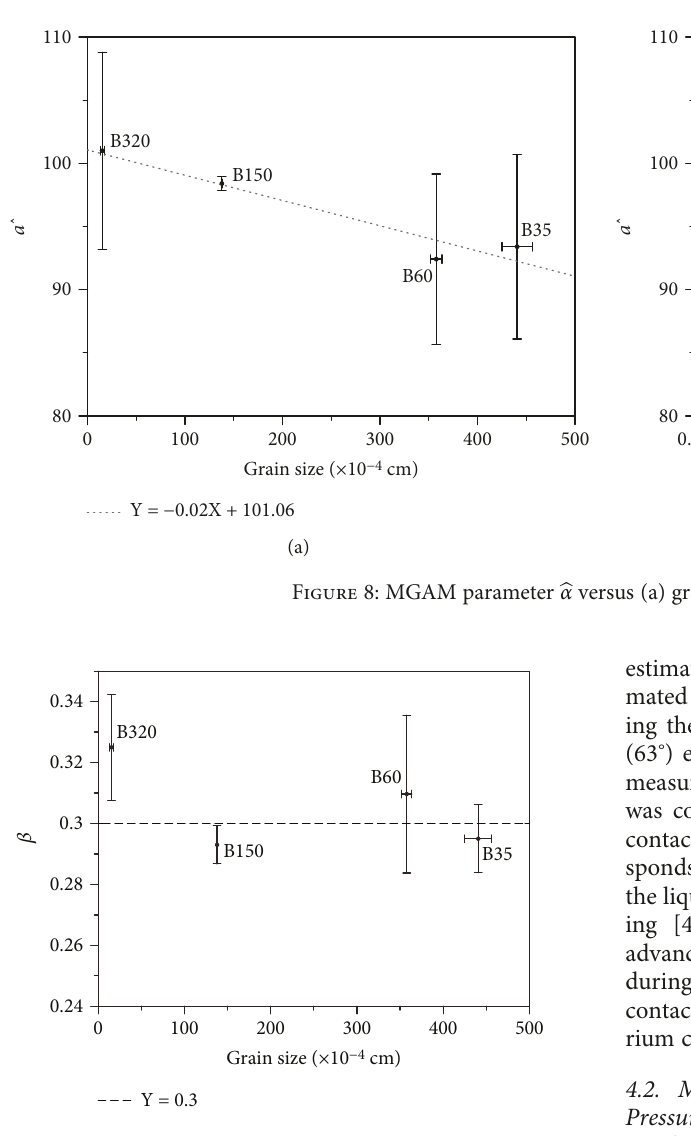
Figure 9: MGAM parameter β versus grain size. The fi tted β was approximately